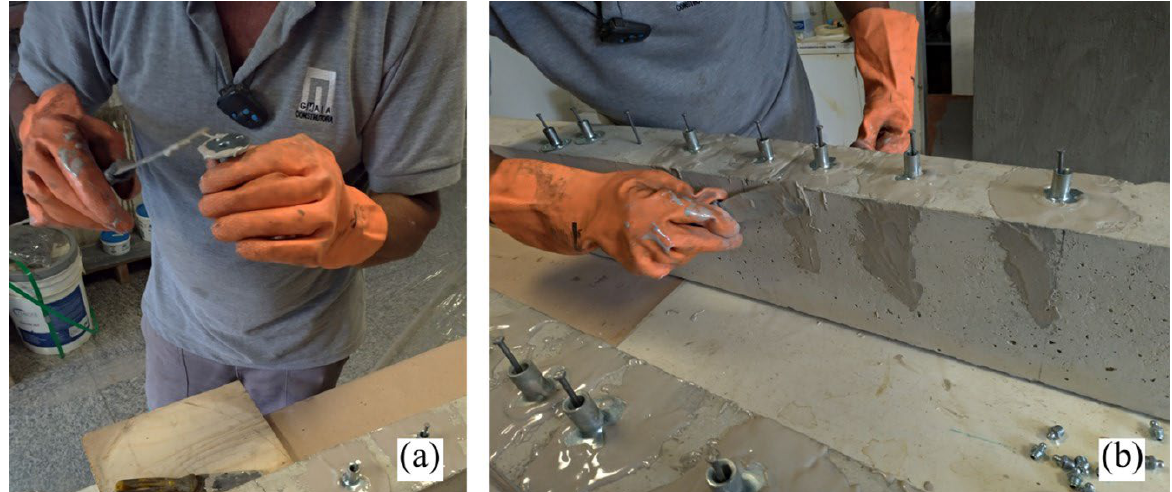
Figure 5. Gluing of surface packers (a); sealing the cracks